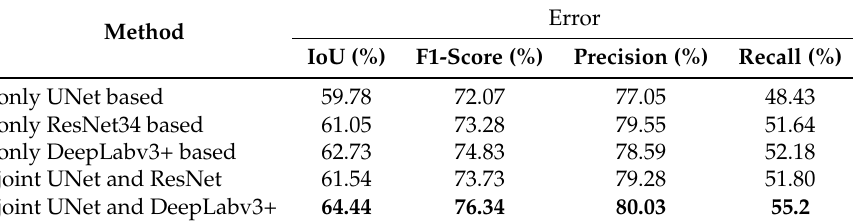
Table 2. Quantitative results for the IoU, F1-score, precision, and recall metrics evaluated on the test area covering 50km 2 .